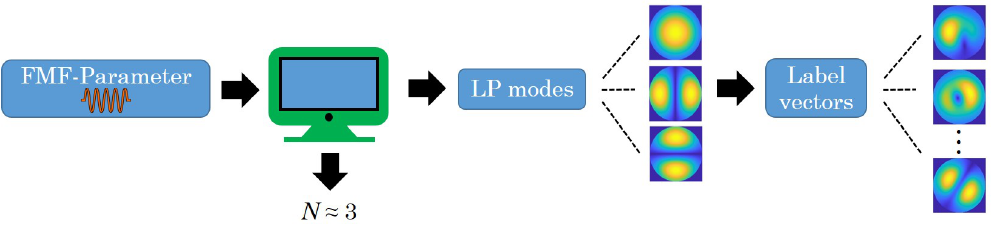
Figure 2. With a selected FMF and known parameters, the modes, which can be guided through the waveguide, can be calculated. Specified mode combinations are then generated, resulting in ensembles of a label vector and a corresponding intensity distribution.